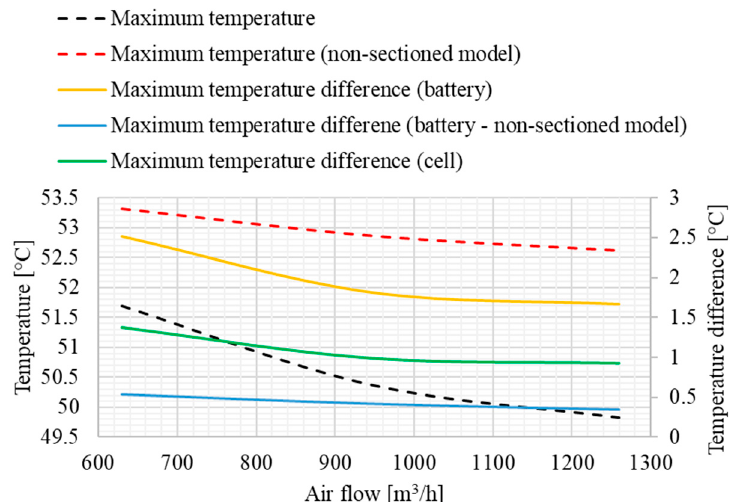
Figure 14. Thermal performances of the analyzed battery segment.